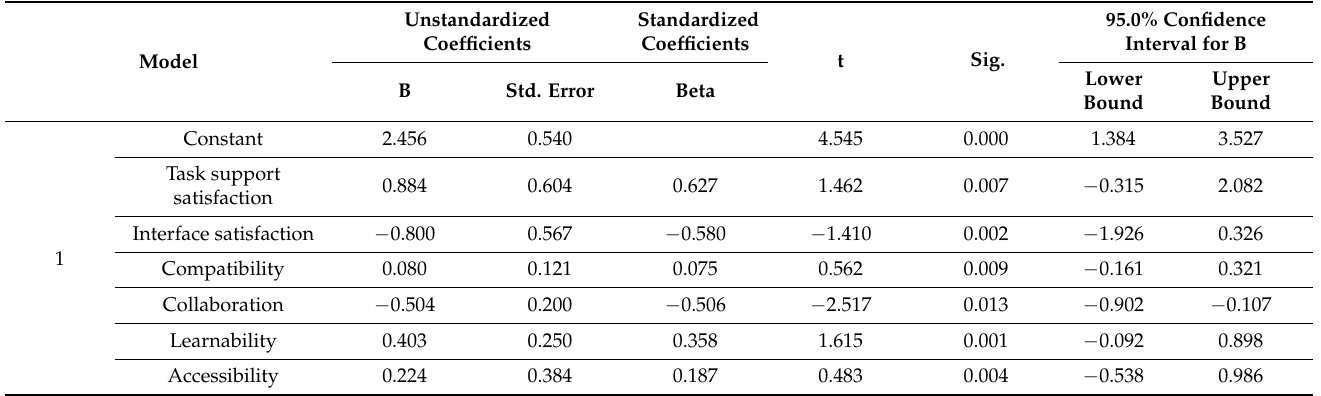
Table 13. Coefficients for the HIS.